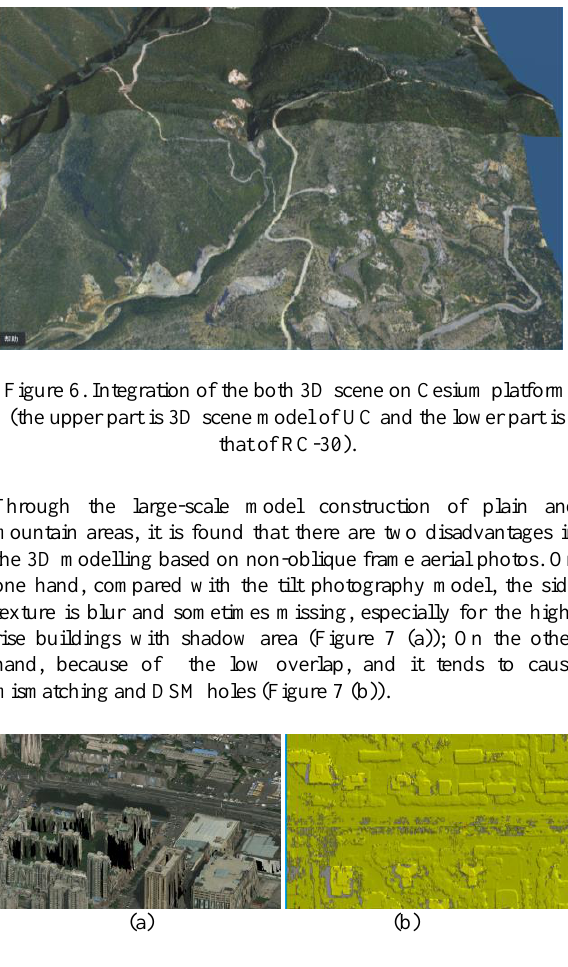
Figure 5. 3D scene model of Beijing in 2015 by the archived UC Figure 7. Disadvantages of the 3D scene model with non-oblique digital frame photos in comparison with 3D scene model in2017 frame photos. (a) Missing side texture for the shadow area of by tilt photogrammetry. (a) and (b) 3D scene model of UC and high-rise buildings; (b) DSM holes caused by mismatching of RC-30 in the urban area; (c) and (d) 3D scene model of UC and moving RC-30 in the mountain area; (e) and (f) 3D scene model for irregular buildings in urban area.